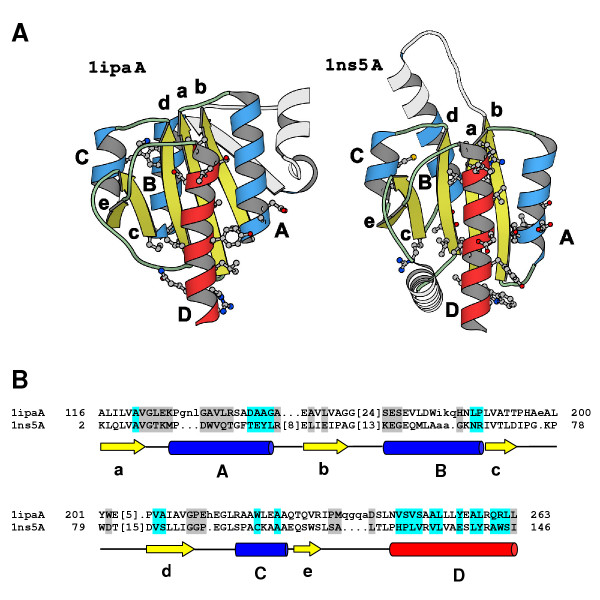
Analysis of positional differences in protein families can reveal potential sites of functional specificity. Comparison of structurally equivalent positions in the multiple alignments of sequence homologs for two distant relatives, 2'-O ribose methyltransferase from T. thermophilus (PDB ID 1ipaA) and hypothetical protein Ybea from E. coli (PDB ID 1ns5A). A. The ribbon diagrams of the structurally similar domain fragments (1ipaA, residues 116–263, and 1ns5A, residues 2–146) drawn by BobScript, a modification of the MolScript program [50]. Similar secondary structure elements are colored in blue (α-helices) and yellow (β-strands). The C-terminal helix D, which is involved in dimerization, is highlighted in red. Ball-and-stick models of sidechains are shown for the residues that (i) have Cα distance less than 2A in the superimposed structures of the two domains, and (ii) correspond to significantly different positions in the multiple sequence alignments of the compared families (P < 0.01). In the ball-and-stick models, C, N, O, and S atoms are shown in gray, blue, red, and yellow, respectively. B. Structure-based sequence alignment of the two domains. The α-helices and β-strands are displayed as arrows and cylinders, respectively. Highlighted: the protein positions that have significantly different residue content in the two corresponding multiple alignments of sequence homologs detected by PSI-BLAST. Cyan, spatially close protein positions, with Cα distance in the superimposed structures less than 2A; gray, position pairs with higher Cα distances.